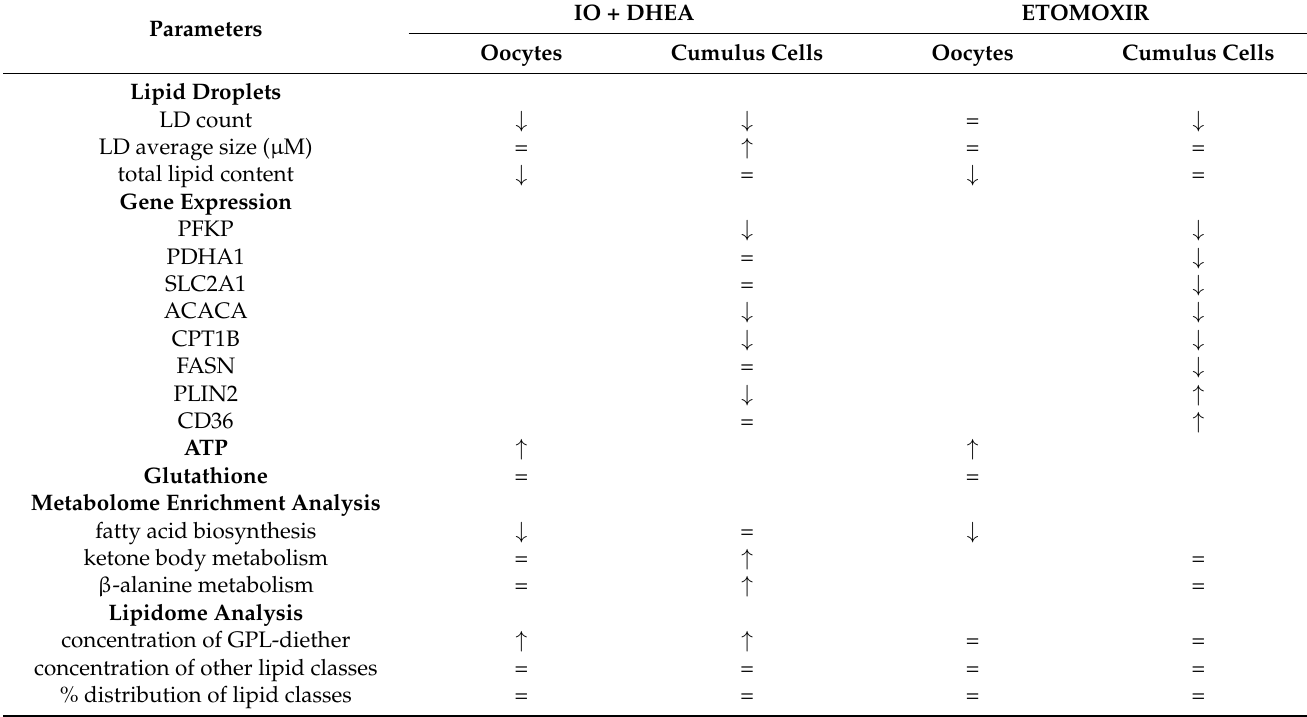
Table 3. Summary of the most important and significant results of the experiments observed within the cumulus–oocyte complex. The table shows the comparison of experimental groups vs. control. ↓ —significant downregulation of the parameter; ↑ —significant upregulation of the parameter; =—no significant change of the